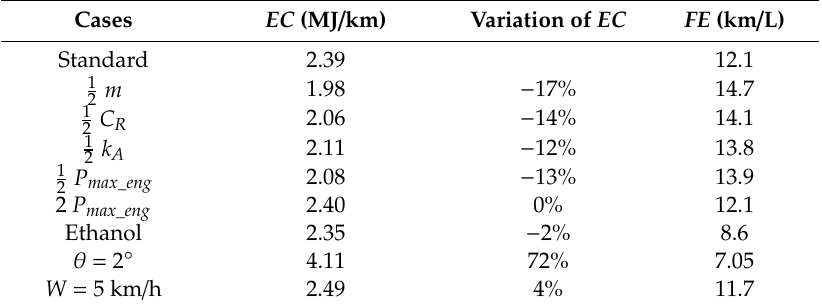
Table 11. Energy consumption variation for simulation changes for FTP-75